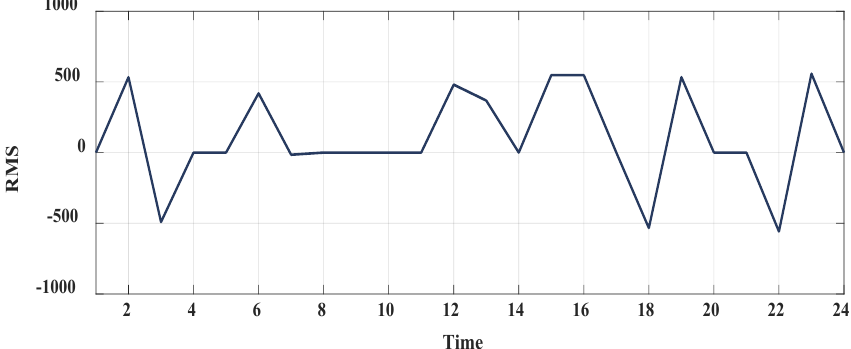
Figure 12. The RMS value based on the digital twin